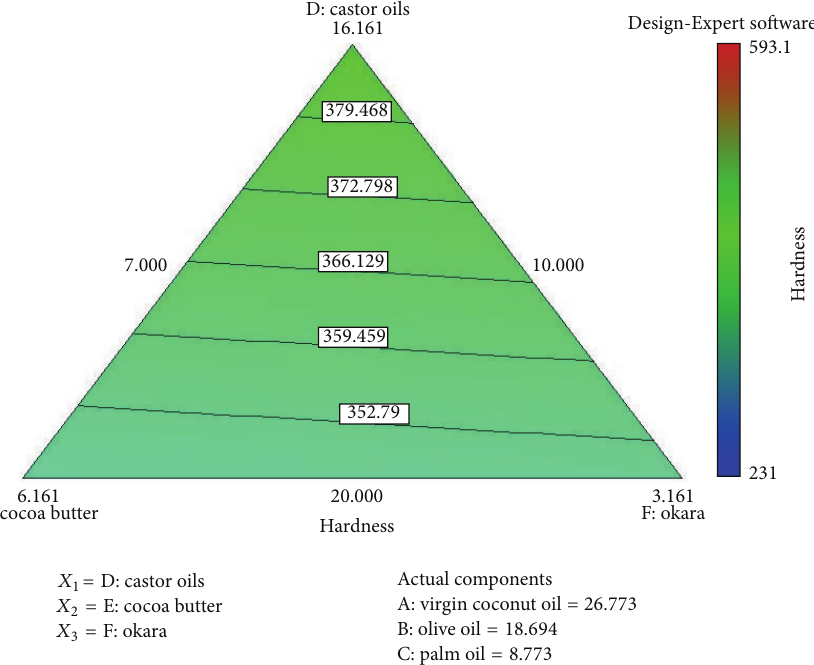
Figure 4: Contour plot that illustrates the relationship between component palm oil, cocoa butter, and okara towards the response, hardness